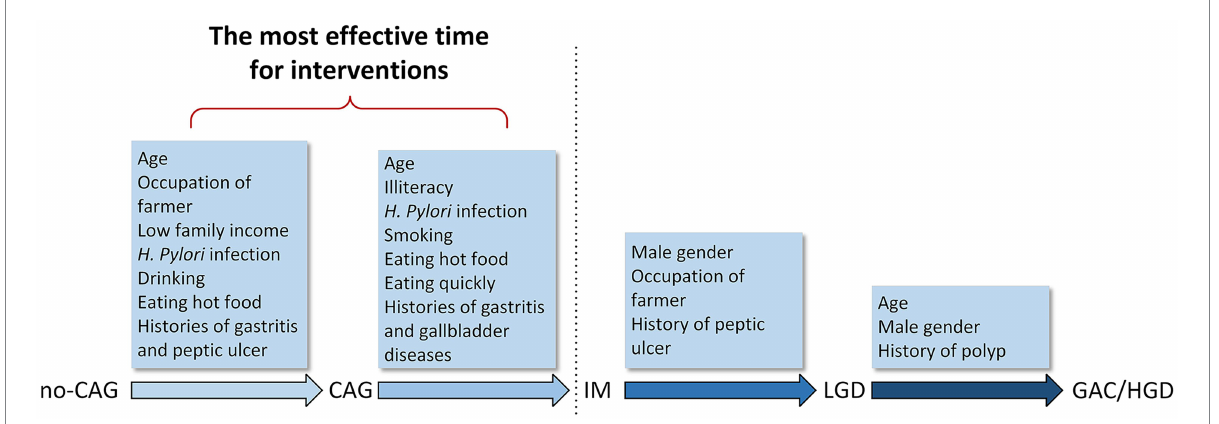
FIGURE 2 Risk factors in the development of gastric adenocarcinoma. Different groups of risk factors associated with different stages from no-CAG to GAC/ HGD. no-CAG, chronic non-atrophic gastritis; CAG, chronic atrophic gastritis; IM, intestinal metaplasia; LGD, low-grade dysplasia; HGD, high- grade dysplasia; GAC, gastric